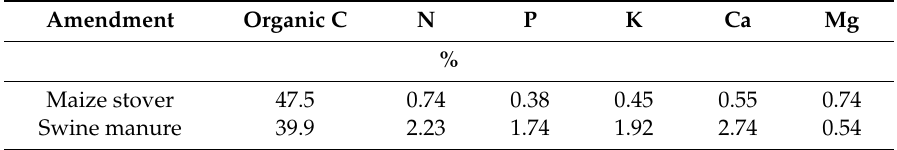
Values are means ( n =